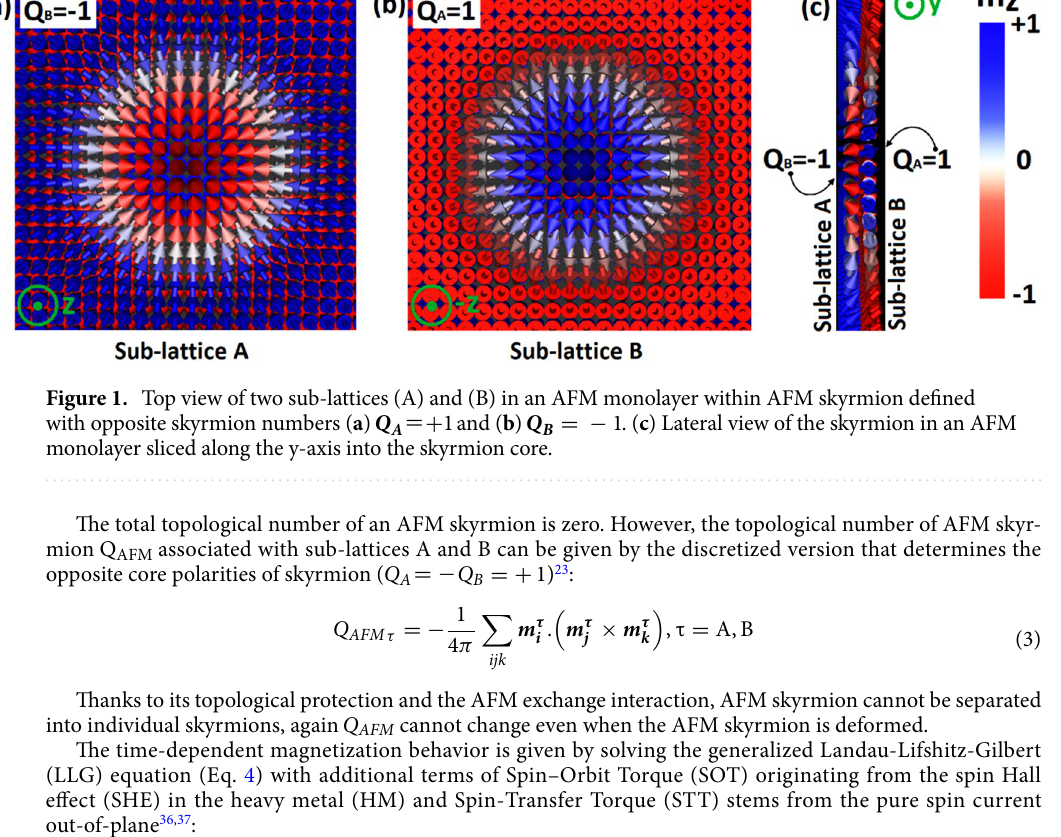
1 . ( c ) Lateral view of the skyrmion in an AFM 1 and ( b ) Q B = − = +